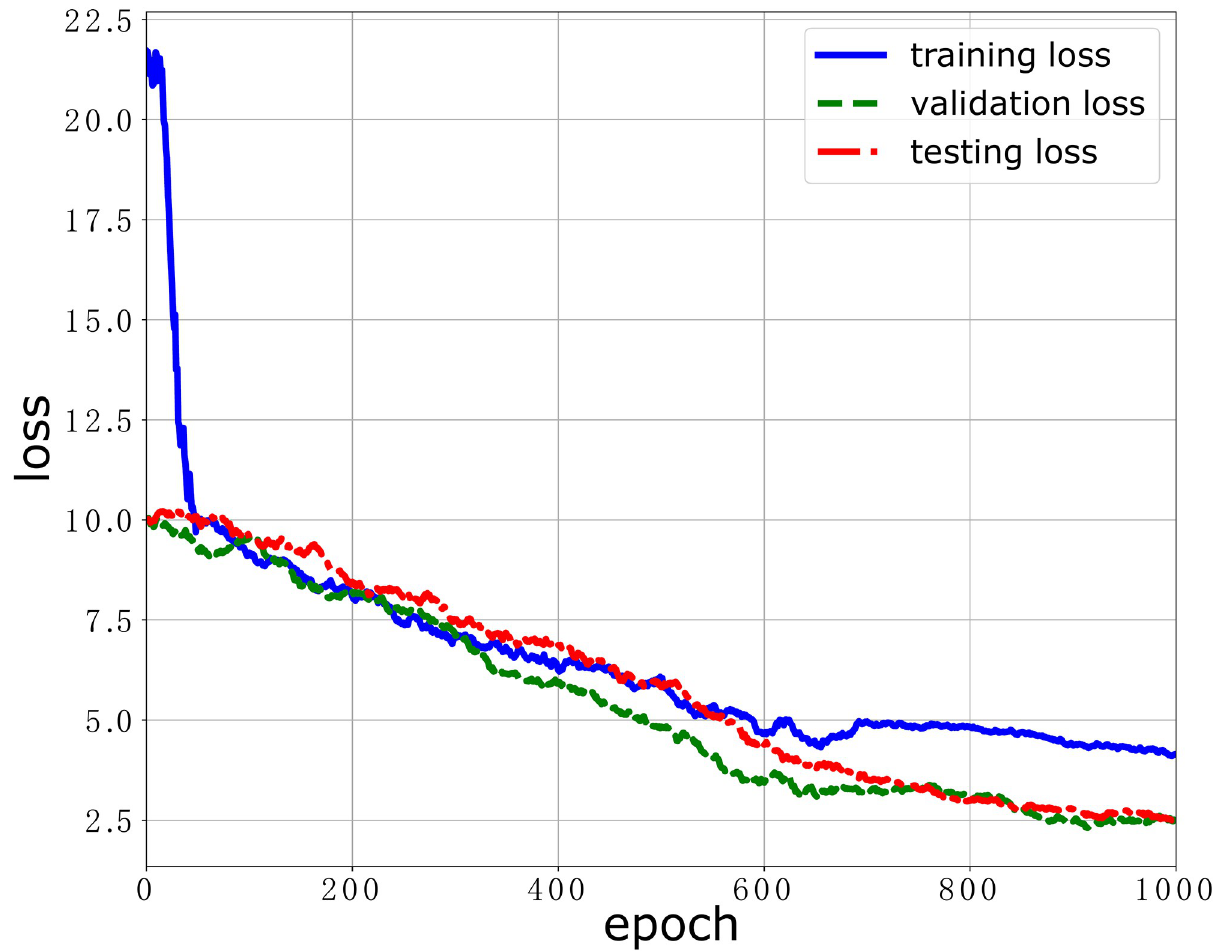
Fig 4. The model loss performance of our DNN model over the ESI dataset.